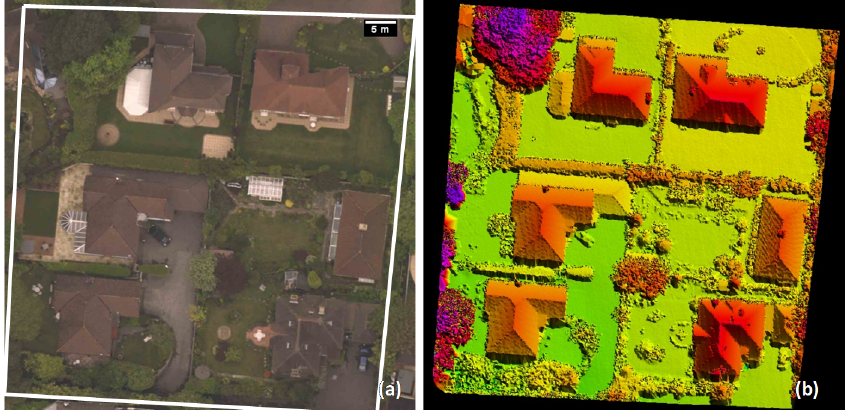
Figure 7. Interest area illustrated by: ( a ) orthophoto ( b ) digital surface model.